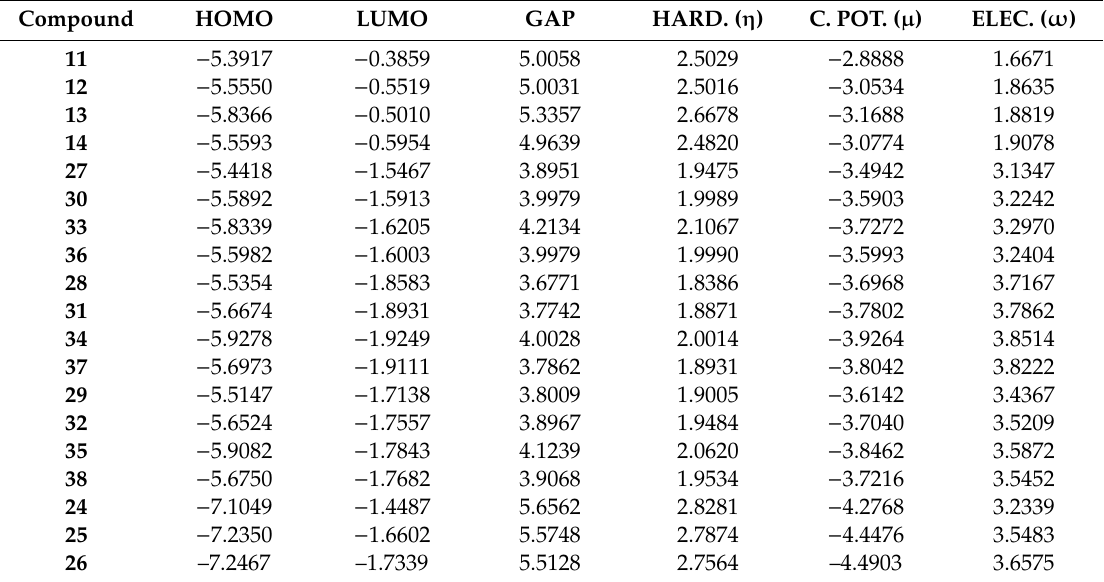
Table 8. Calculated energies (eV) for FMOs and reactivity indexes, for precursors and final